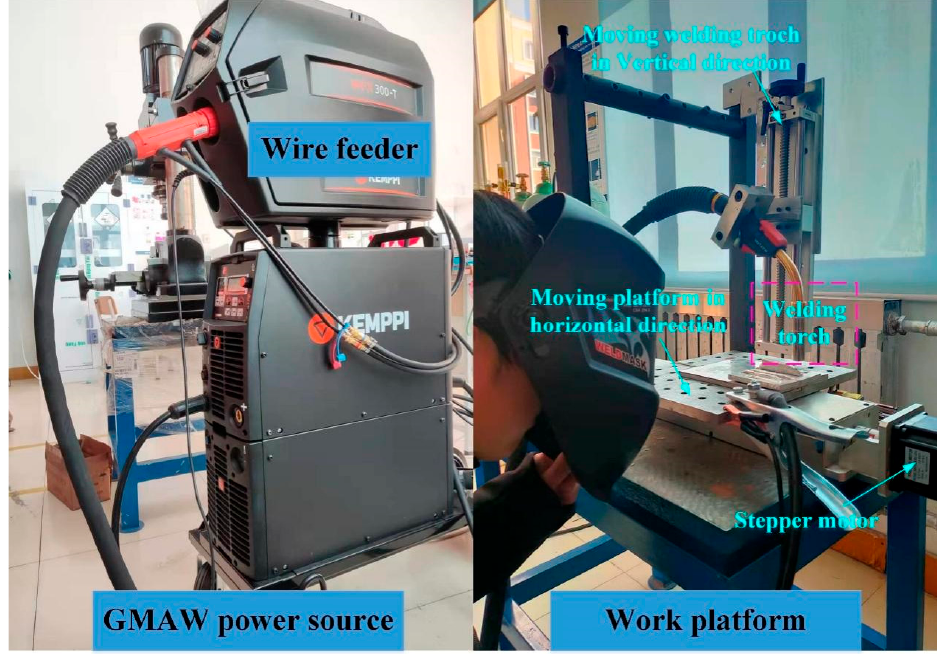
Figure 1. The external longitudinal magnetic field hybrid gas metal welding additive manufacturing (M-GMAW-AM) system.